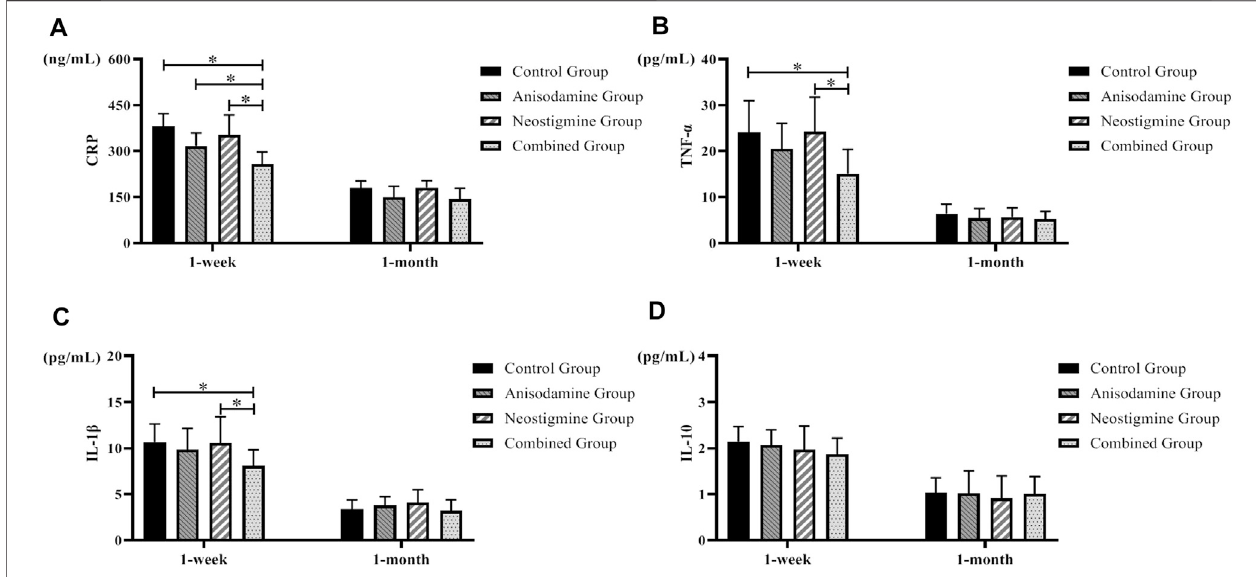
FIGURE 3 | Changes of in fl ammatory indexes in rats at different time points after the RCJS procedure (* refers to the comparison between the two groups, p < 0.05). Comparison of (A) CRP (ng/ml), (B) TNF- α (pg/ml), (C) IL-1 β (pg/ml), and (D) IL-10 (pg/ml) at different time points in rats of each group.